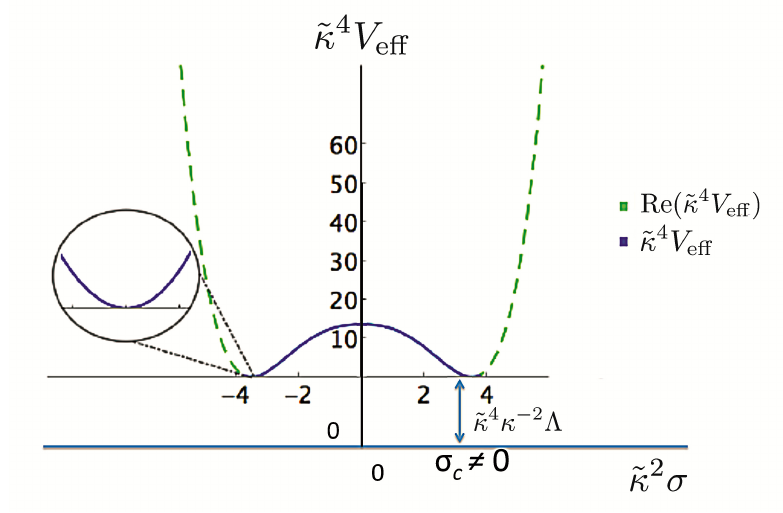
Figure 2. Generic shape of the one-loop effective potential (in dimensionless units ˜ κ 4 V eff , where ˜ κ is the conformally-rescaled gravitational coupling; see the text) for the gravitino condensate field σ in dynamically-broken (conformal) supergravity models in the presence of a non-trivial de Sitter background with cosmological constant Λ > 0 [9]. The Starobinsky inflationary phase is associated with fluctuations of the condensate and gravitational field modes near the non-trivial minimum of the potential, where the condensate σ c (cid:54) = 0 and the potential assumes the value Λ > 0, consistent with supersymmetry breaking. The dashed green lines denote “forbidden” areas of the condensate field values, violating the condition (17), for which imaginary parts appear in the effective potential, thereby destabilizing the broken symmetry